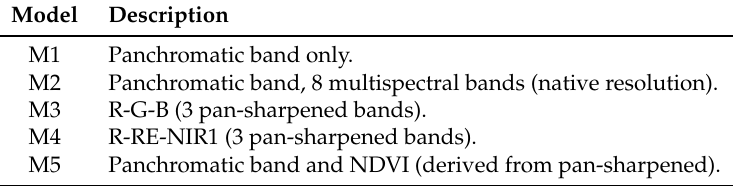
Table 2. Data Models. A different U-net semantic segmenter was trained for each of M1 to M5. Model Description M1 Panchromatic band only. M2 Panchromatic band, 8 multispectral bands (native resolution). M3 R-G-B (3 pan-sharpened bands). M4 R-RE-NIR1 (3 pan-sharpened bands). M5 Panchromatic band and NDVI (derived from